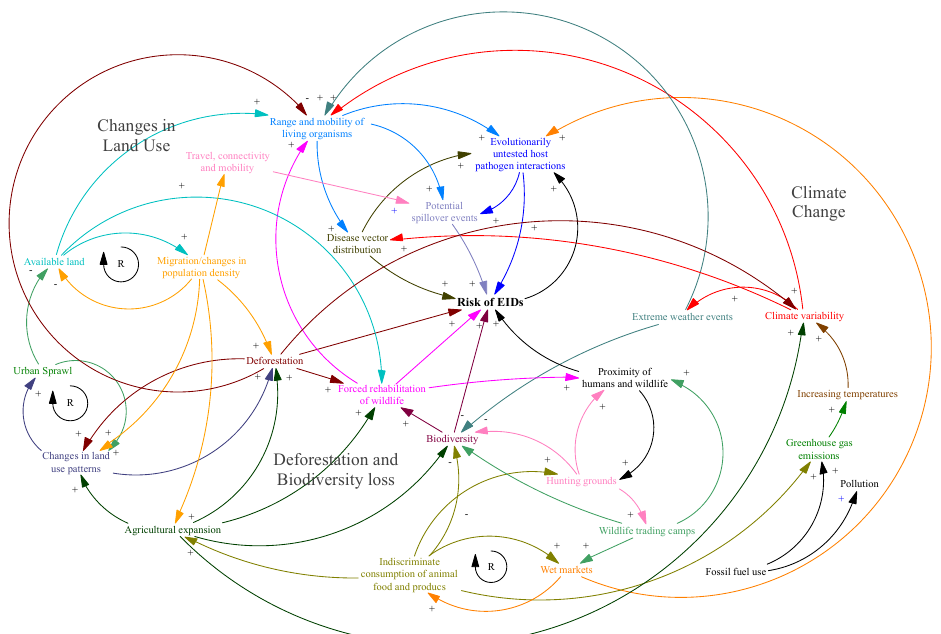
Figure 1. Causal interrelation of drivers for climate change and risk of EIDs. Positive causal links (+) between variables denote a change in the same direction, i.e., direct proportionality between variables. Negative causal links (-) denote a change in opposite directions, i.e., inverse proportionality between variables. Reinforcing causal loops (denoted by an R with a clockwise arrow) are associated with exponential increases/decreases between variables.